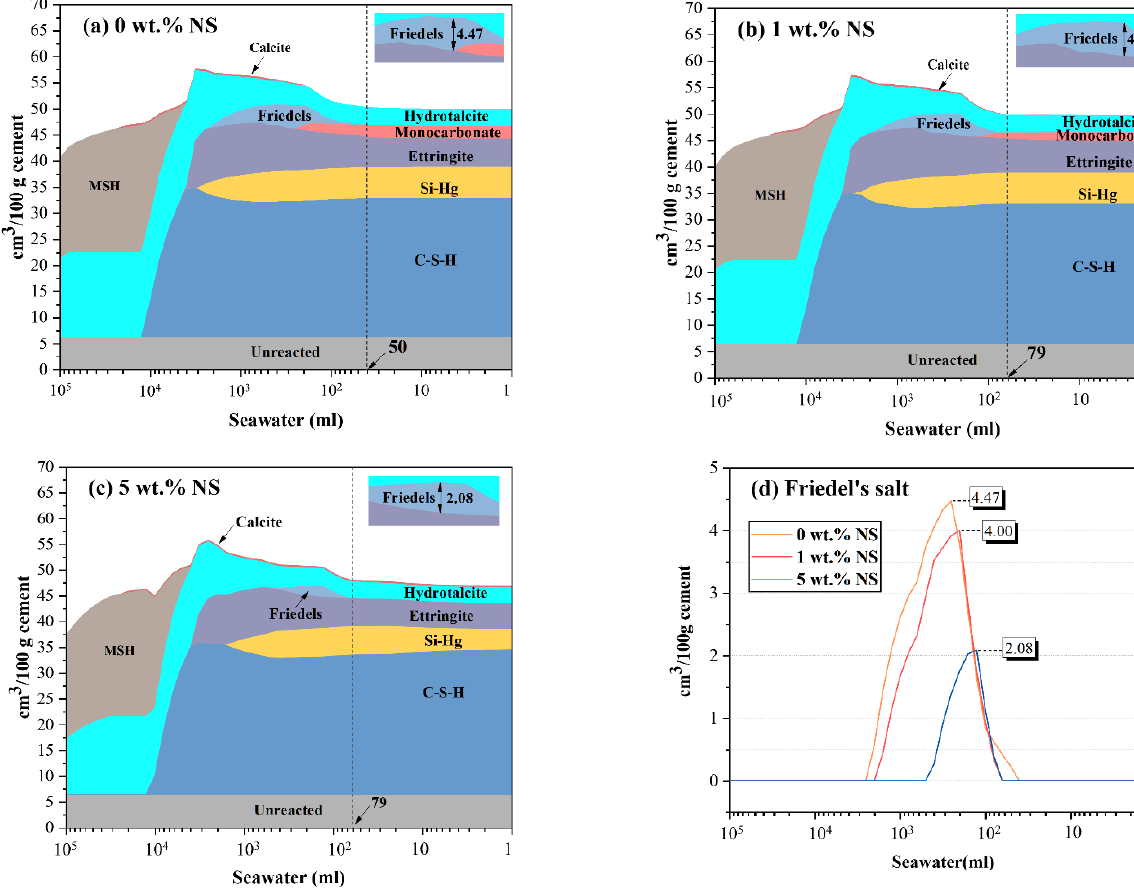
Figure 8. Phase assemblages in the blends incorporated with different content of NS upon exposure to increasing amount of seawater; ( a – c ) total phase assemblages; ( d ) volumes of Friedel’s salt. Table3. Volumes of hydrates before exposure to seawater.